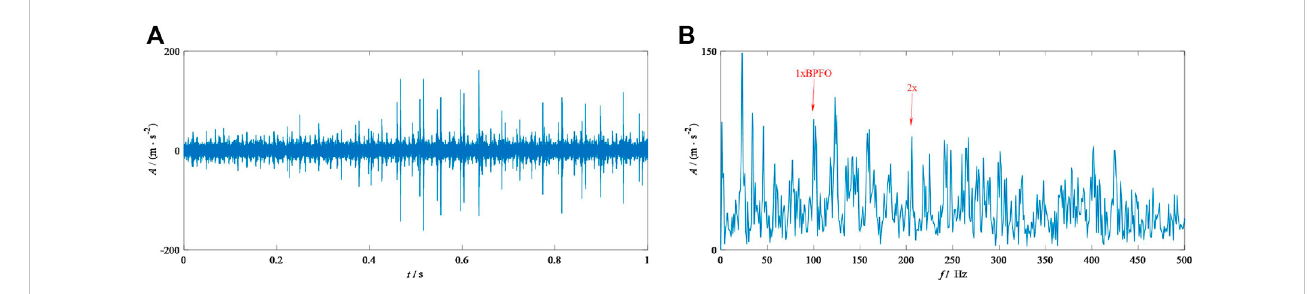
FIGURE 11 Raw signals from CU-O: (A) TDW and (B) SES.